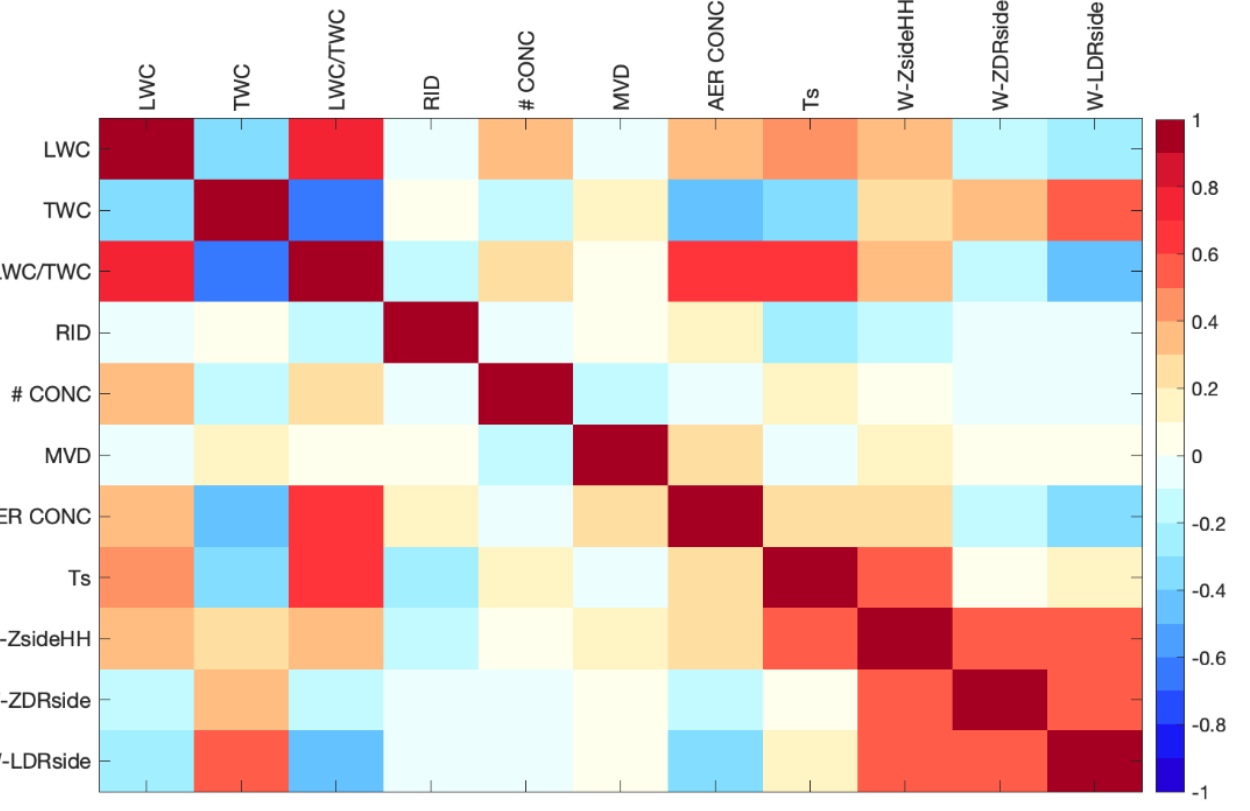
Figure 6. A correlation matrix of input variables in flight F20 (23 February 2019).